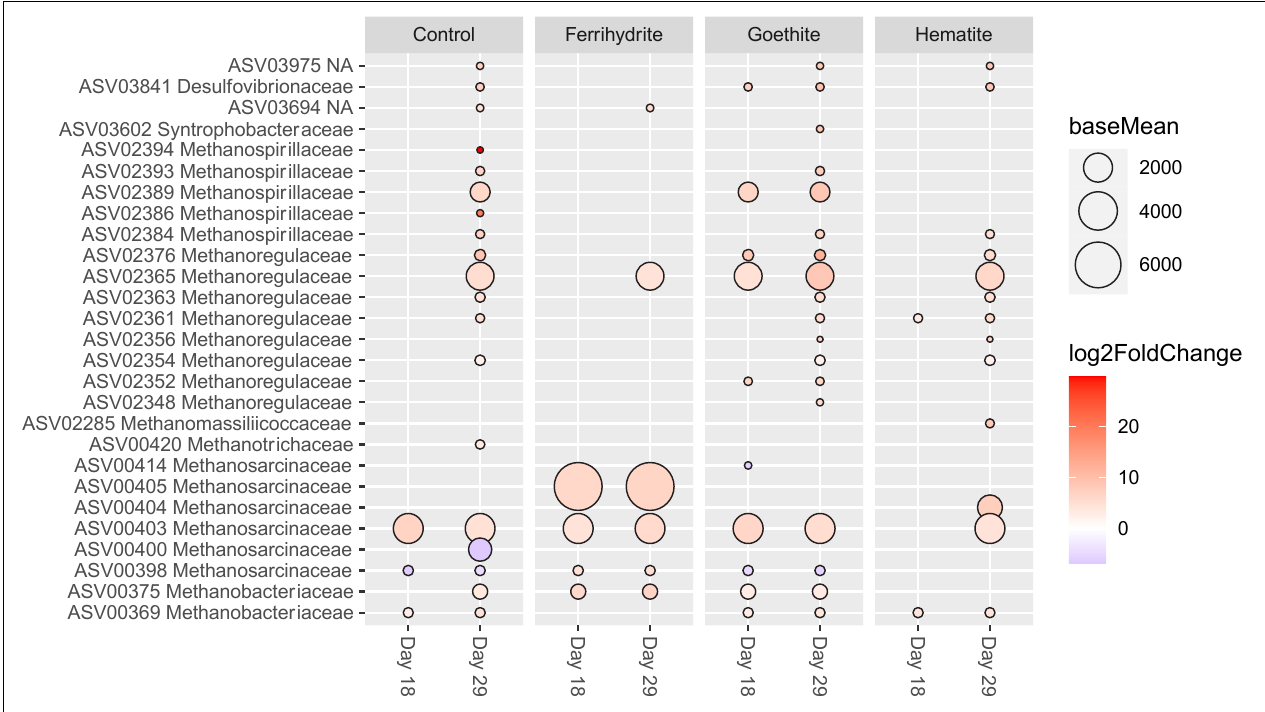
FIGURE 6 | ASVs classified as Proteobacteria and Euryarchaeota with significant ( p < 0.01) log-fold changes ( p < 0.01) over time. Each sample was compared its corresponding “Day 9” sample (e.g., Control Day 29 vs. Control Day 9). The size of the circle corresponds to the normalized mean counts of each ASV, while the color corresponds to the magnitude of the log-fold